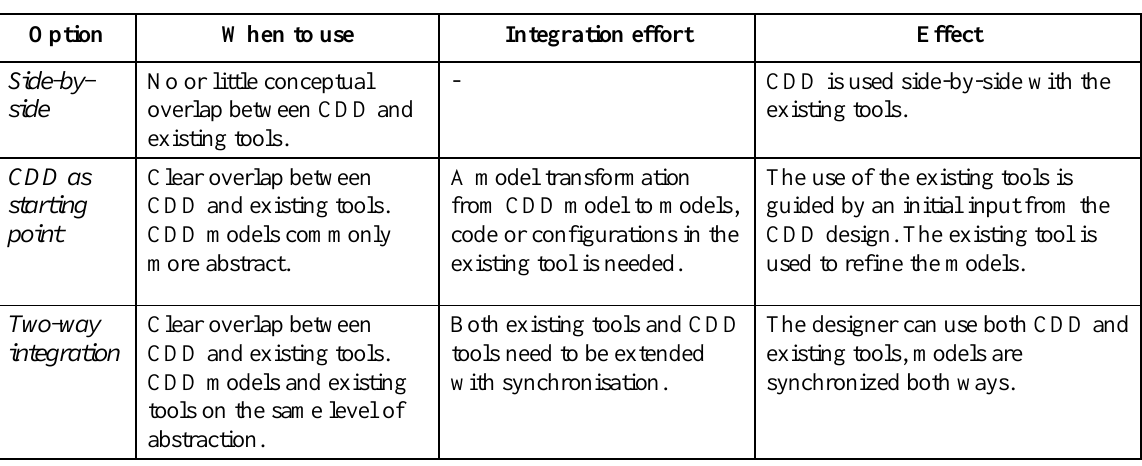
Table 3. Design time integration